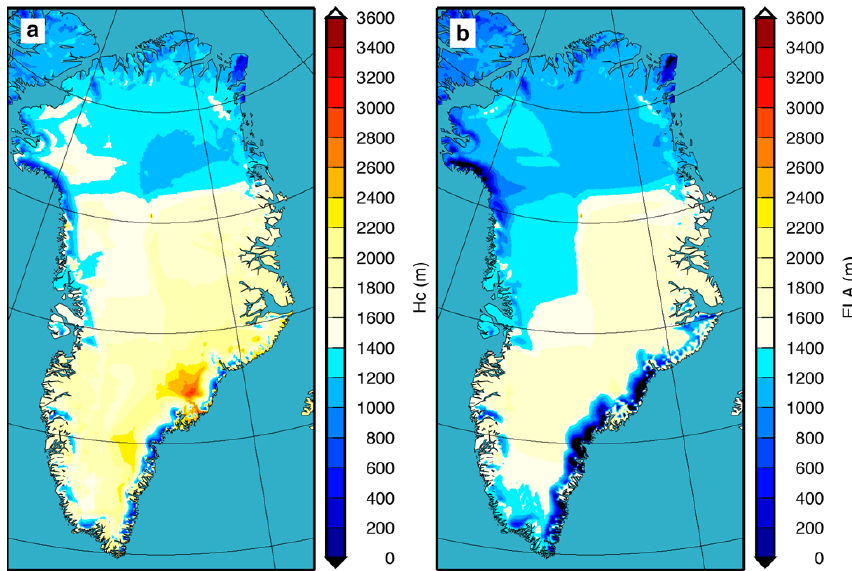
Fig. 5. (a) Elevation of intersection of H s -SMB relations for ablation and accumulation regimes ( H c ) and (b) resulting ELA using the H s -SMB relations.